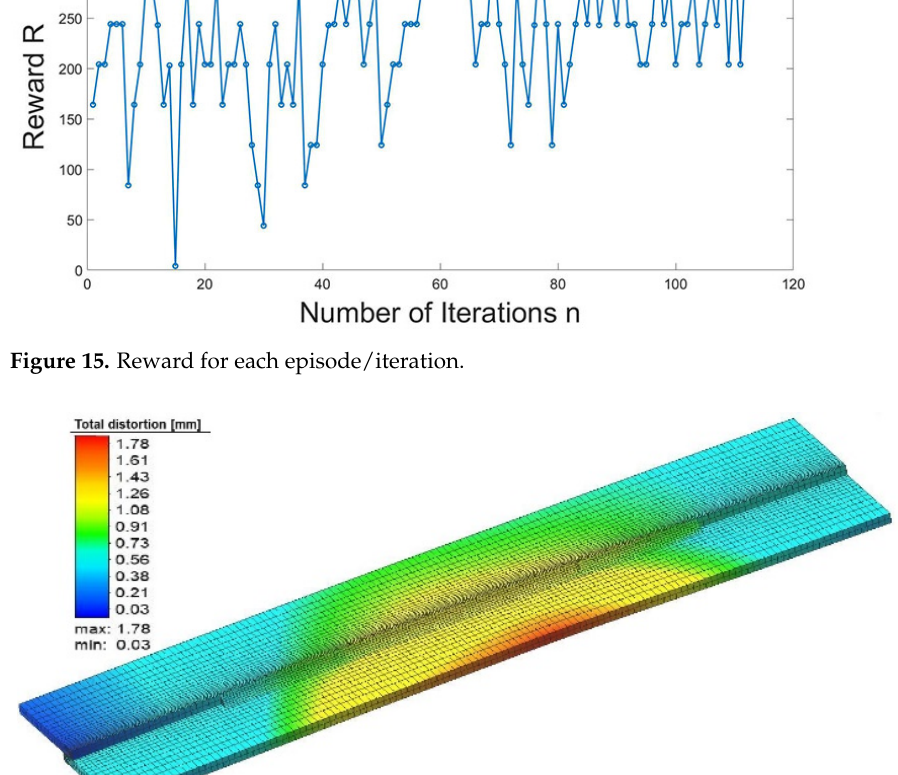
Figure 15. Reward for each episode/iteration.